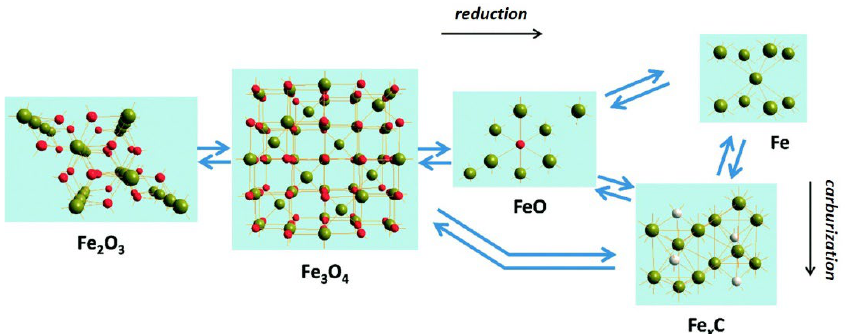
Figure 8. Schematic of the common transformations observed between different iron phases during the Fischer–Tropsch and CO 2 hydrogenation processes. Reprinted with permission from ref. [146] .